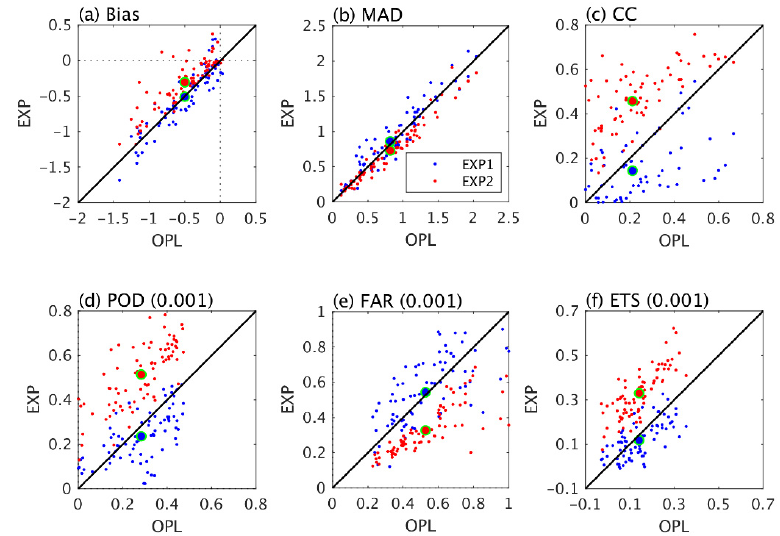
Figure 4. Scatter plot of the statistics of hourly domain-mean precipitation (mm/hr) from WRFDA experiments against that from the open-loop experiment. The circles with green edges represent mean values.